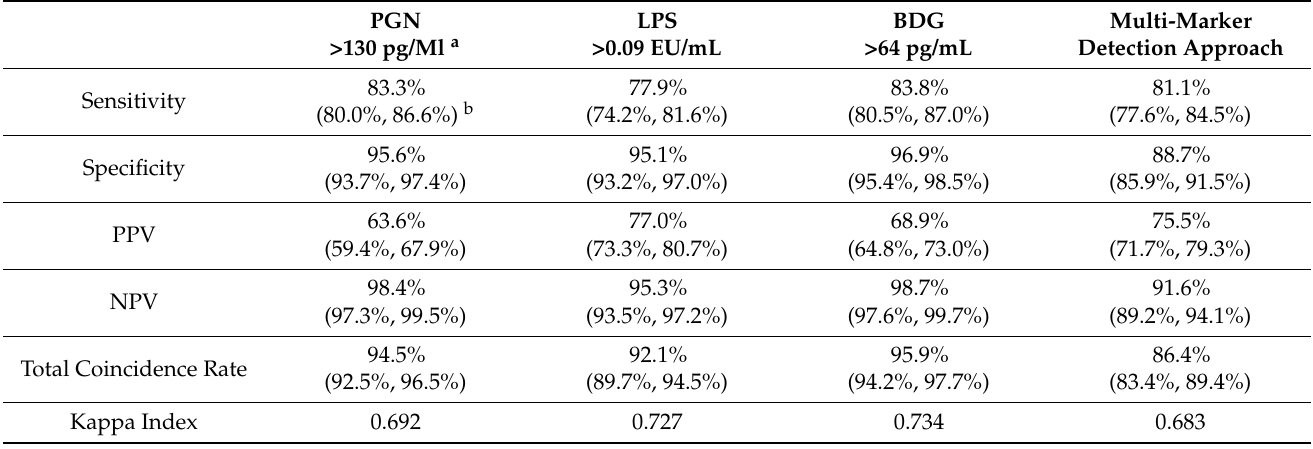
Table 3. Results of the related indexes in PGN, LPS, and BDG and the multi-marker detection